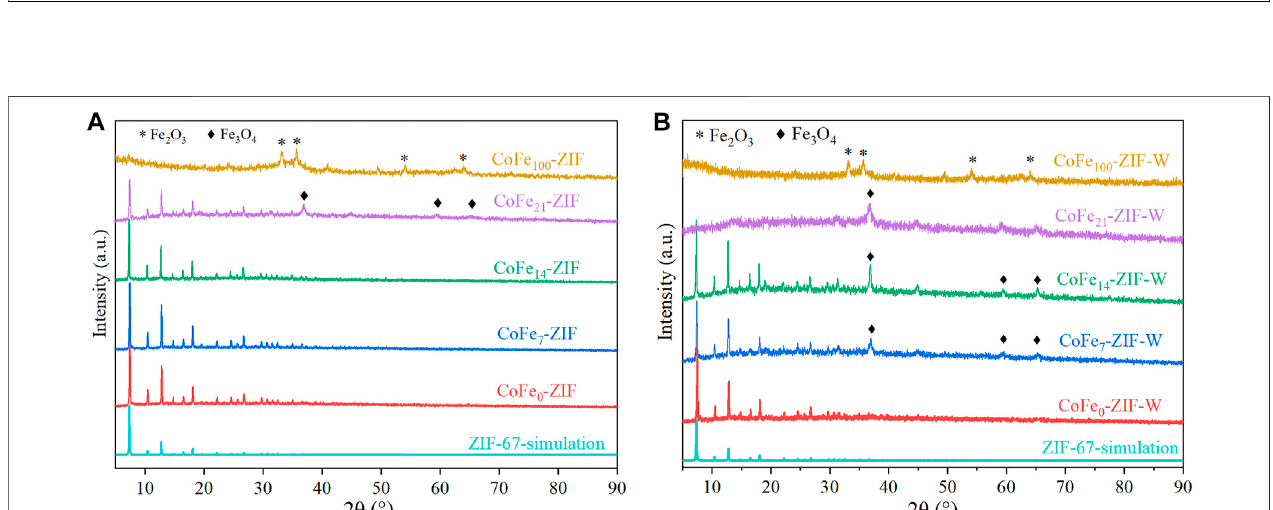
Frontiers in Energy Research |